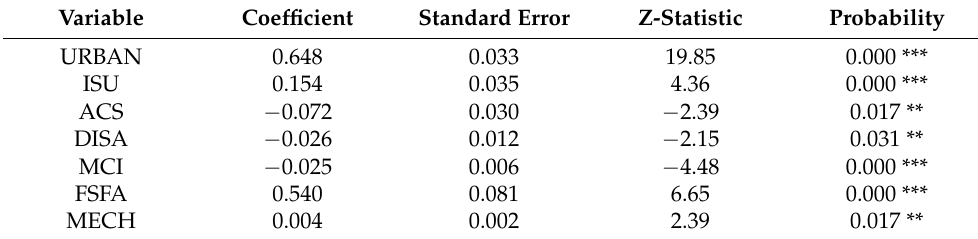
Figure 1. SEM images of the surface of the coatings at different magnifications: ( a , b ) CaP/CS and Figure 5. Spatial distribution pattern of AEE in China. ( c , d ) CaP/CS/CL before aging; ( e , f ) CaP/CS and ( g , h ) CaP/CS/CL after aging in SBF. Table 5. Influencing factors of